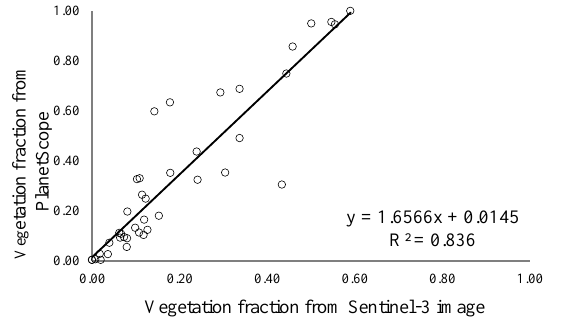
Figure 7. Validation of vegetation fraction estimated from spectral unmixing with those of computed from the PlanetScope image